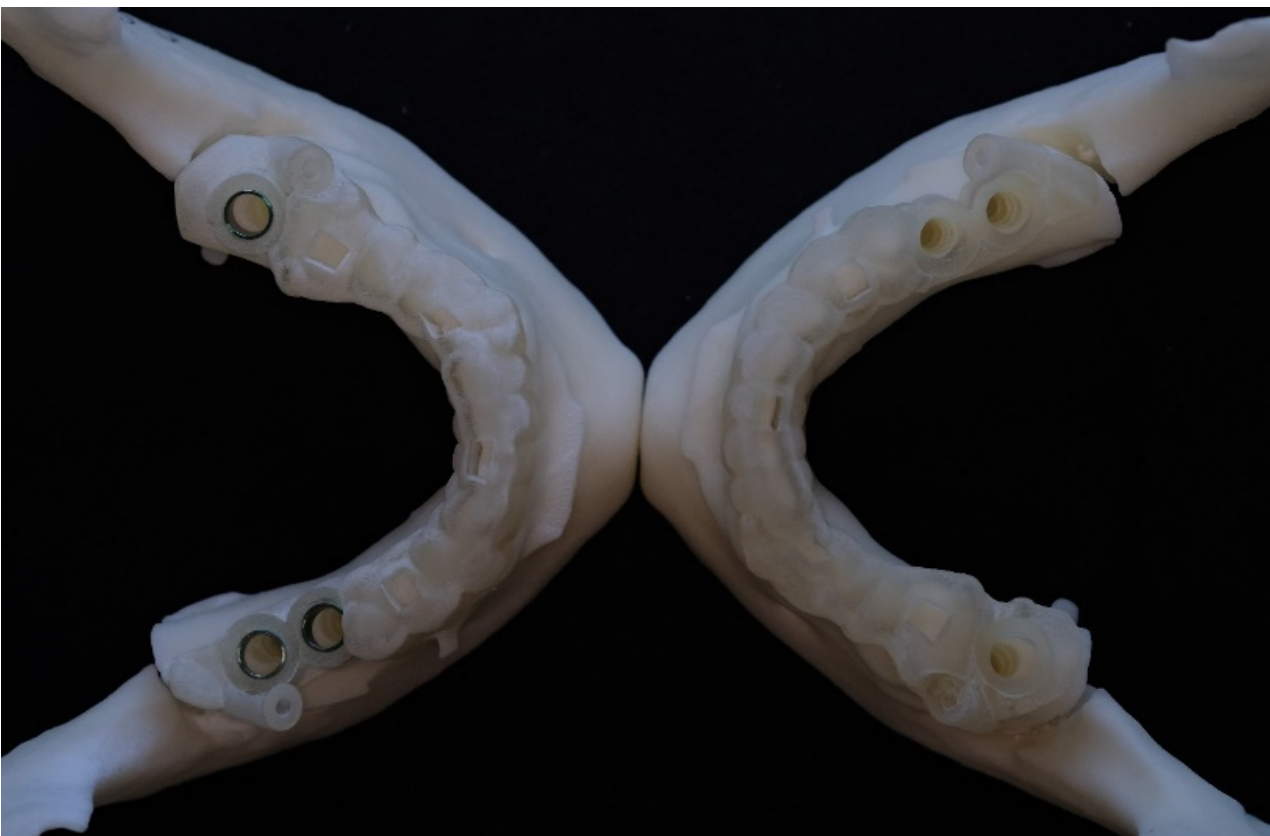
Figure 7. Two types of surgical guides fitted on models.